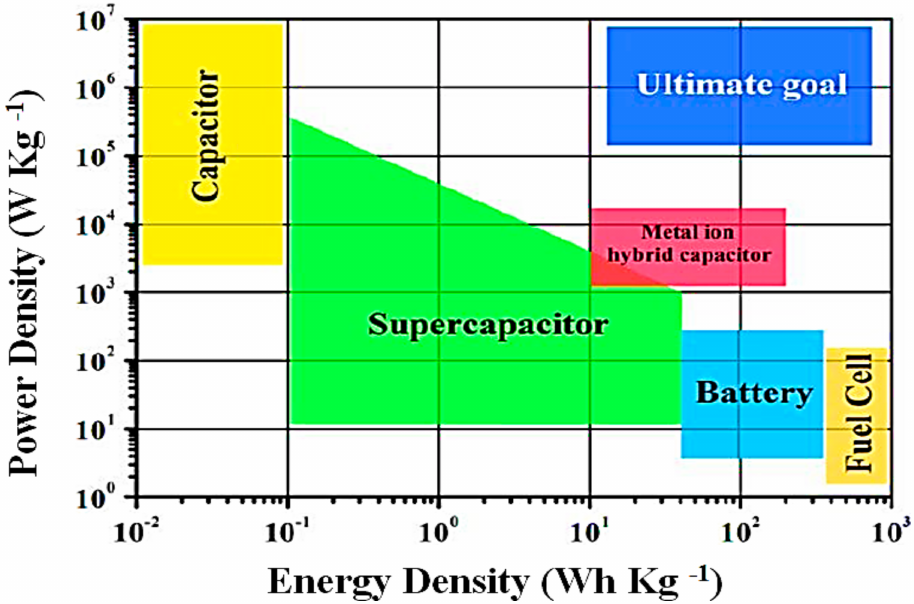
Figure 13. Ragone plot for different storage devices.